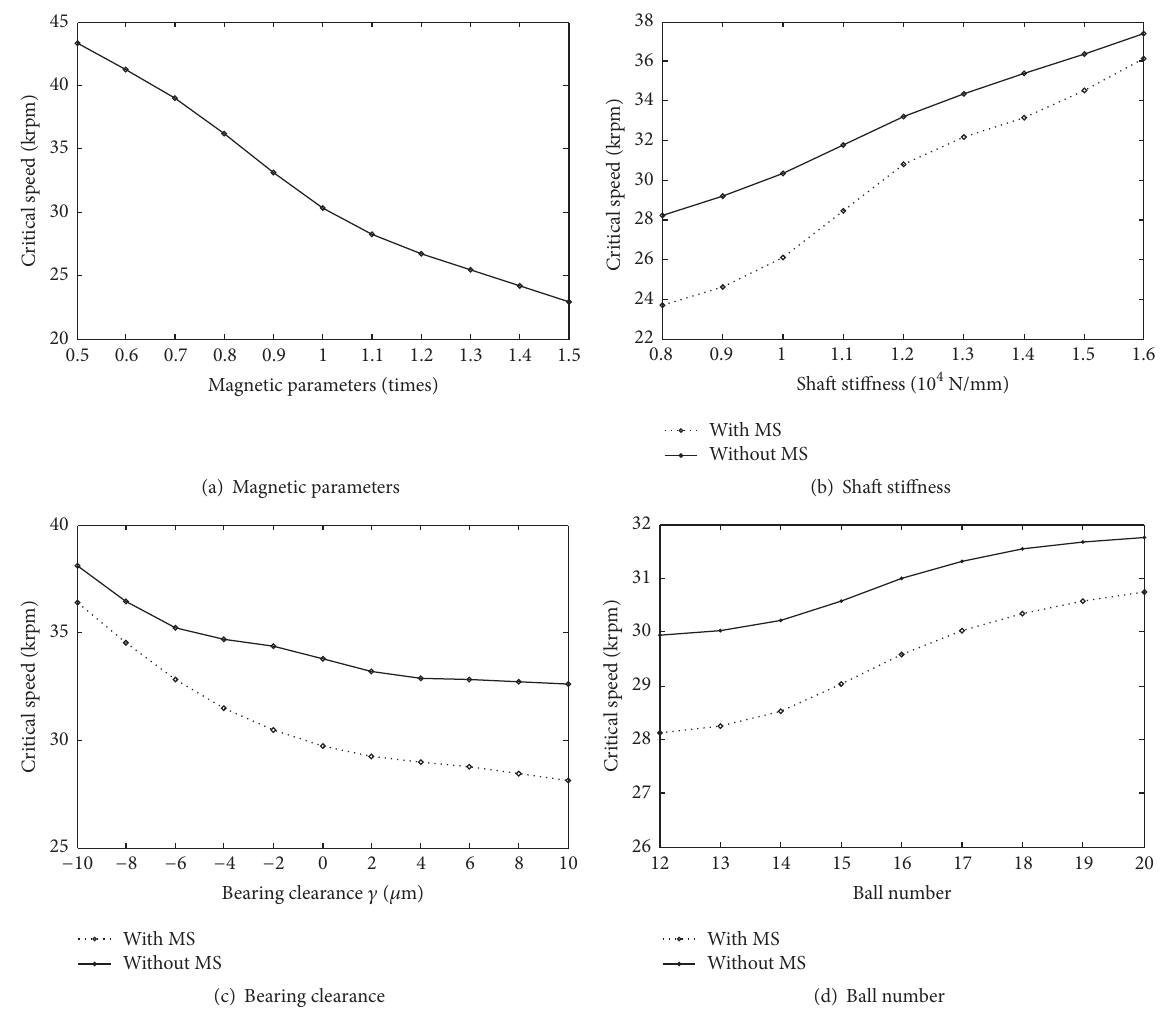
Figure 10: Theoretical influence of system parameters on critical